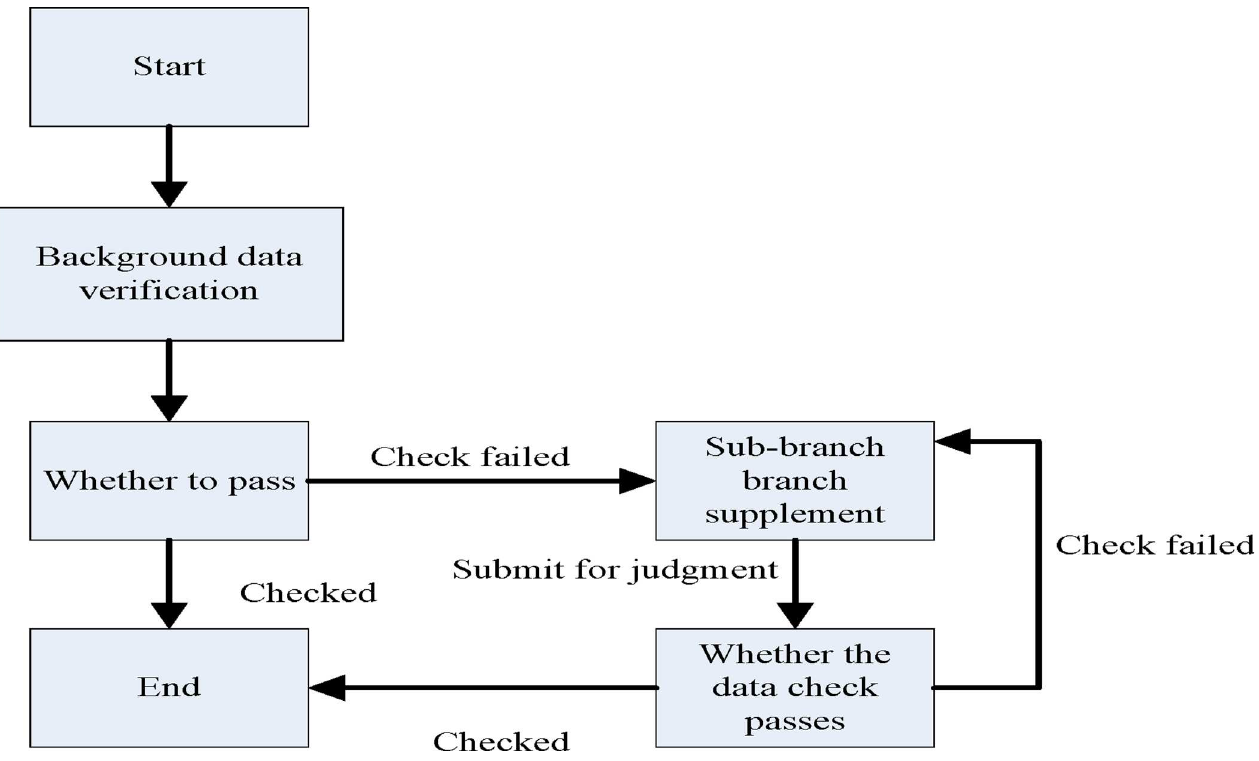
Fig 1. Safety information verification